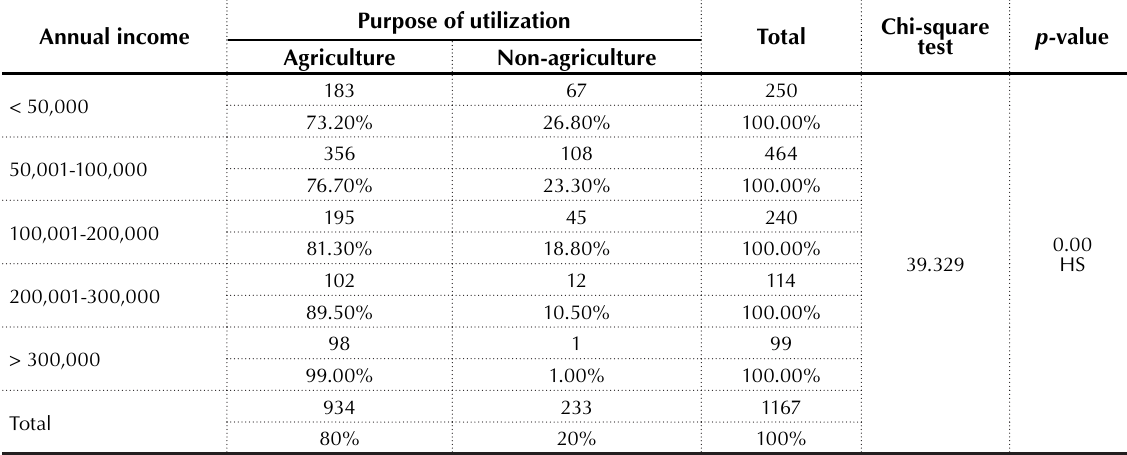
Table 6. Impact of annual income on the purpose of agricultural credit utilization Annual